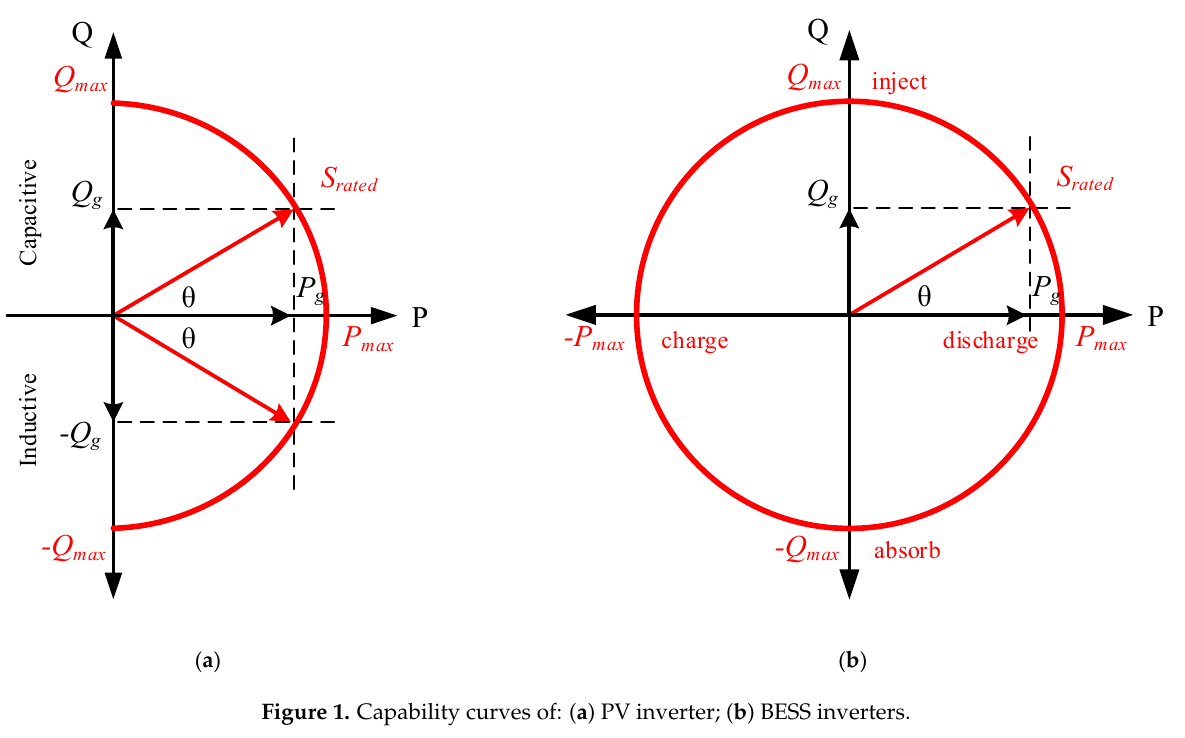
Figure 1. Capability curves of: ( a ) PV inverter; ( b )BESS inverters.